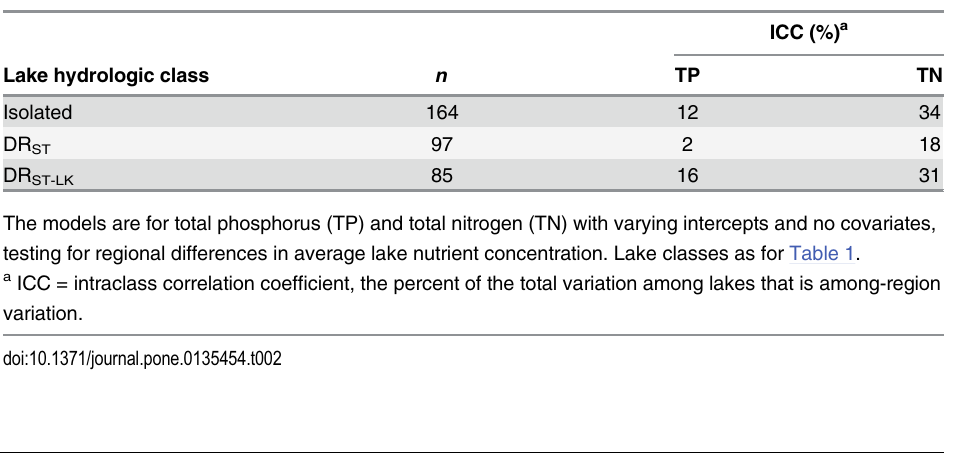
Table 2. Results from the unconditional mixed-effect models.